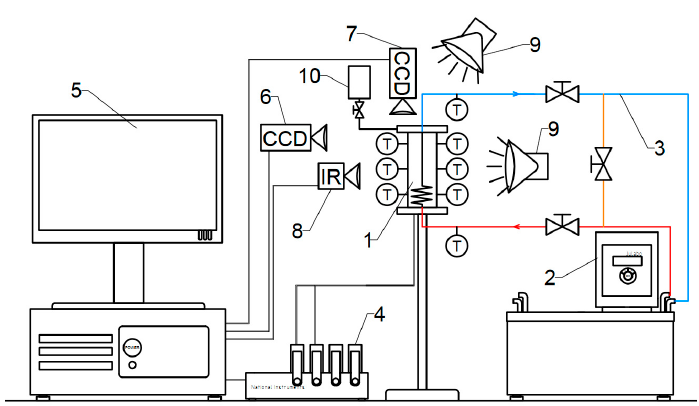
Figure 1. Scheme of experimental test section: 1—experimental module; 2—thermostat with bath; 3— thermostatic loop; 4—data acquisition system; 5—PC; 6—front camera; 7—top camera; 8—thermal imaging camera; 9—photographic lamps; 10—filling vessel.